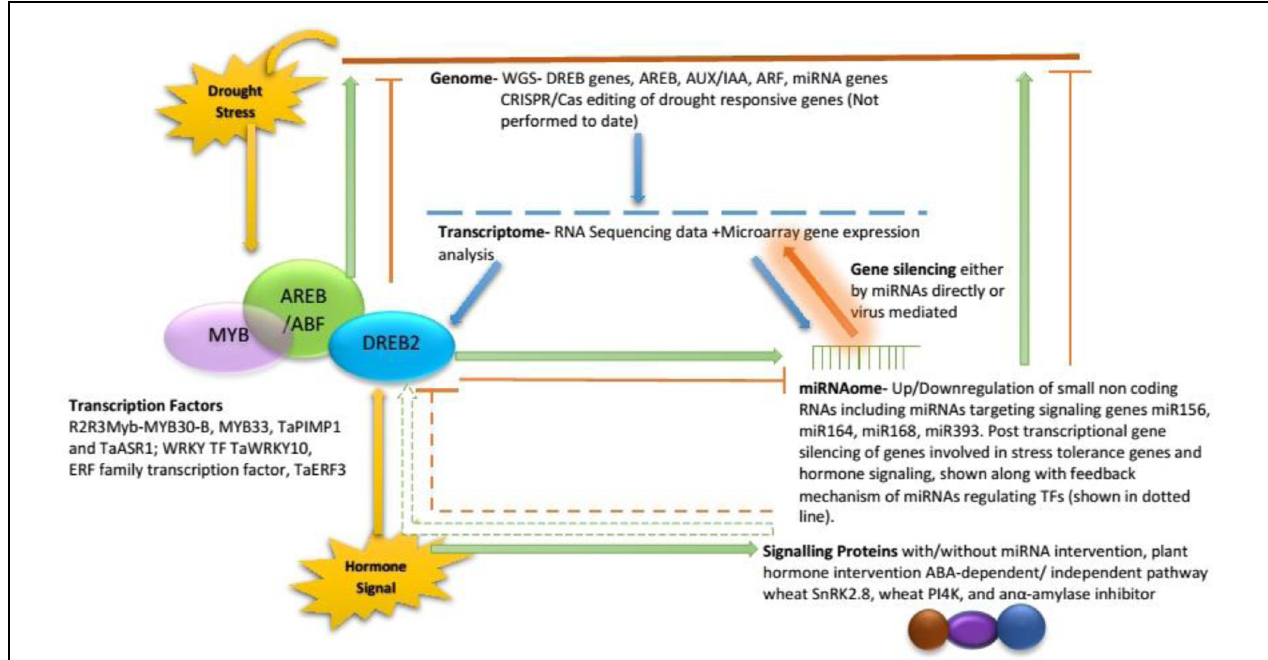
FIGURE 2 | Putative stress signaling pathway in wheat where functional genomics contribute. TABLE 5 | Functional genomics studies for identification of drought signaling molecule in recent years. Functional genomics